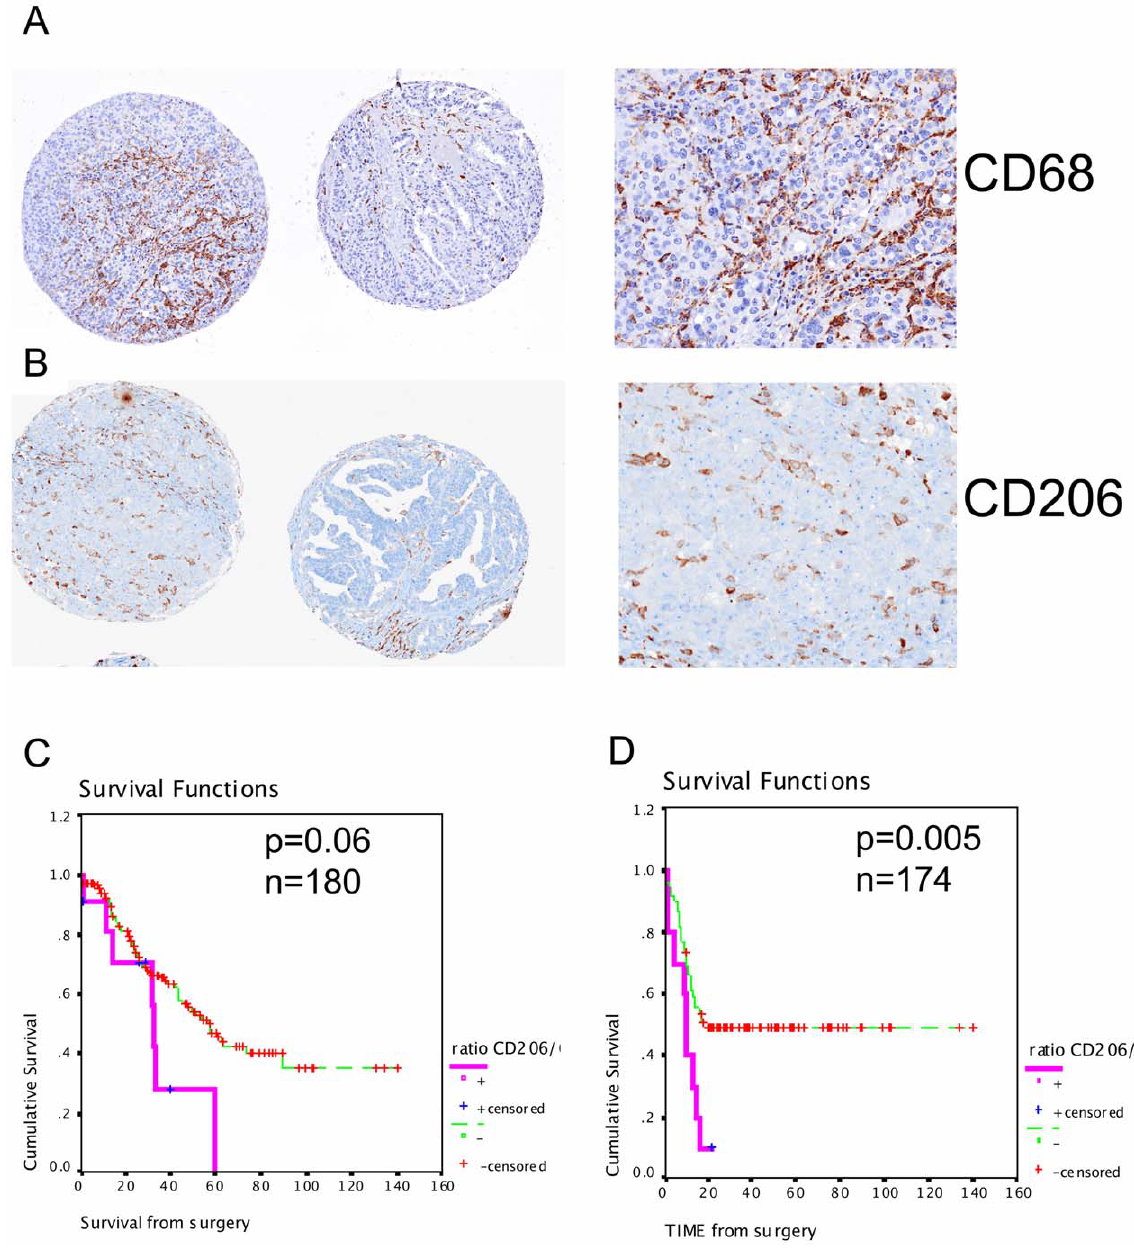
Figure 4. Representative staining for immunohistochemistry of infiltrating macrophages. High and low density of CD68 + (tumor- associated macrophages, TAM) (A) and CD206 + (M2 subtype of TAM) cells (B). Magnification in the high infiltration area is shown on the right panel for each staining (top). C and D. Kaplan-Meier analysis of the ratio of infiltrating intraepithelial CD206 + /CD68 + cells representing the relative density of CD206 + M2 TAM over the total density of CD68 + intraepithelial infiltrating macrophages. Kaplan-Meier curves of overall survival (C) and disease- free survival (D) in 180 and 174 patients, respectively. Significance (p) is indicated by log rank.